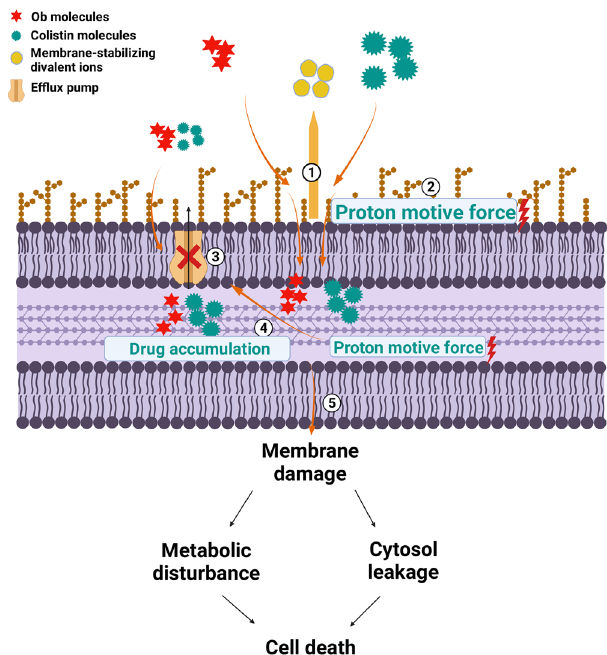
Fig. 10 Proposed antimicrobial mechanisms of the Ob and colistin combination on colistin-resistant E. coli . Ob acts synergistically with colistin to cause membrane permeabilization by displacing the membrane- stabilizing divalent ions ① . The Ob and colistin combination also causes dissipation PMF ② and inhibits drug ef fl ux ③ , resulting in accumulation of the two agents and disruption of electron transport chain activities, which in turn leads to further dissipation of PMF, reduction in ef fl ux activities, and accumulation of the drugs ④ . The collapse of PMF and extensive membrane damages result in cytosol leakage and eventually cell death ⑤ . The fi gure was created using